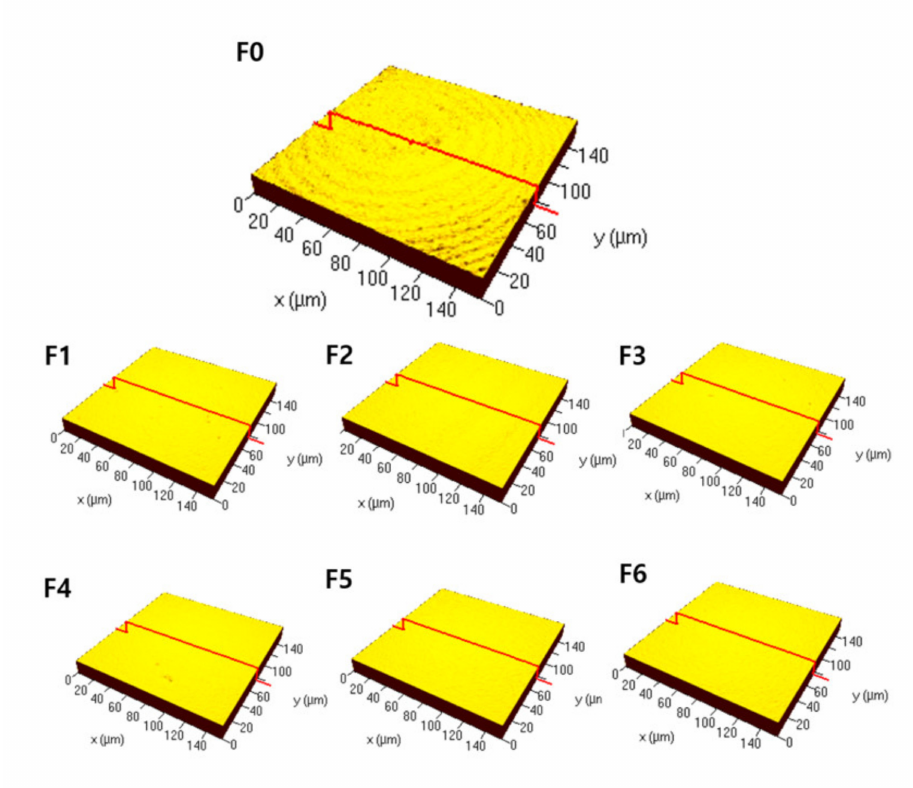
Figure 2. Representative surface profiles with enlarged pictures for the experimental groups (F0–F6); red lines indicate surface